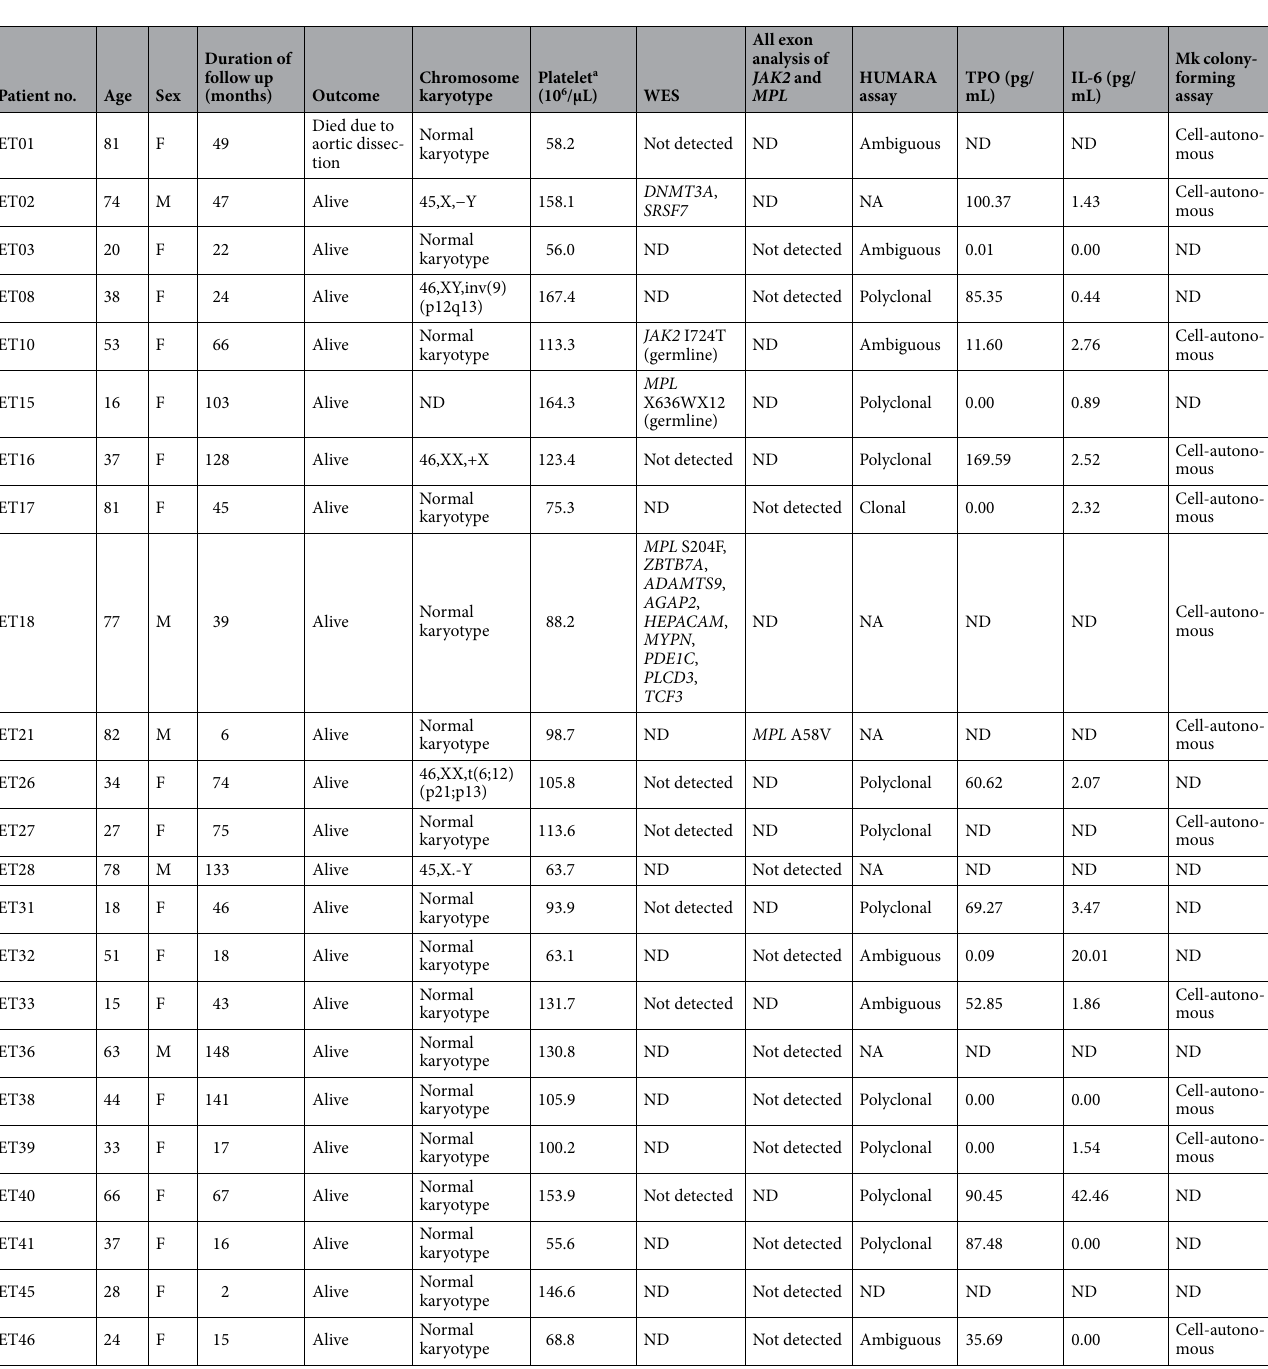
Table 2. Clinical, biological, and genetic characteristics of TN-ET patients. WES, whole-exome sequencing; Mk, megakaryocyte; ND, not done; NA, not applicable. *Platelet counts are those from the first